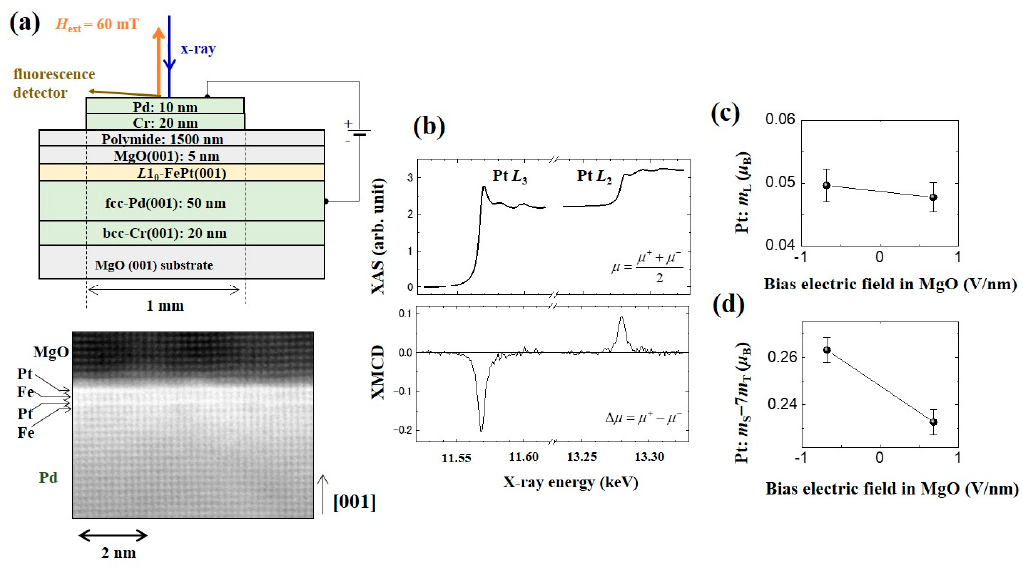
Figure 9. Voltage-induced changes to the magnetic moment of Pt in the Fe / Pt / MgO system. ( a ) Schematic of the sample structure and its high-angle annular dark-field scanning transmission electron microscopy (HAADF-STEM) image. ( b ) Typical XAS / XMCD results around the Pt-absorption edges. ( c ) Voltage-induced change to the orbital magnetic moment in Pt. ( d ) Voltage-induced changes to the e ff ective spin magnetic moment ( m S − 7 m T ) in Pt. Reproduced from [116]. CC BY 4.0.